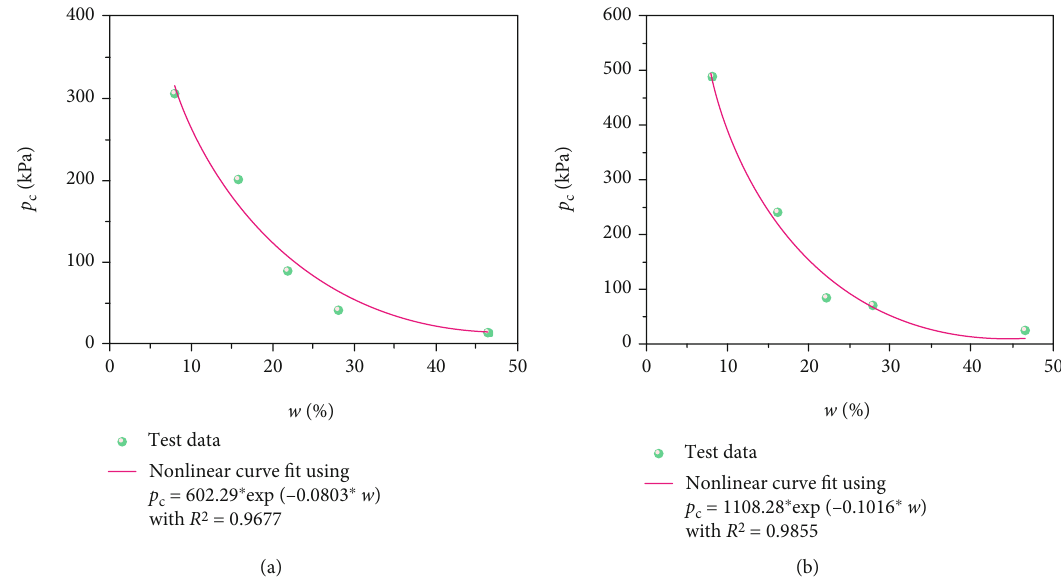
Figure 6: Relation between preconsolidation pressure and moisture content for (a) remoulded loess and (b) undisturbed loess.